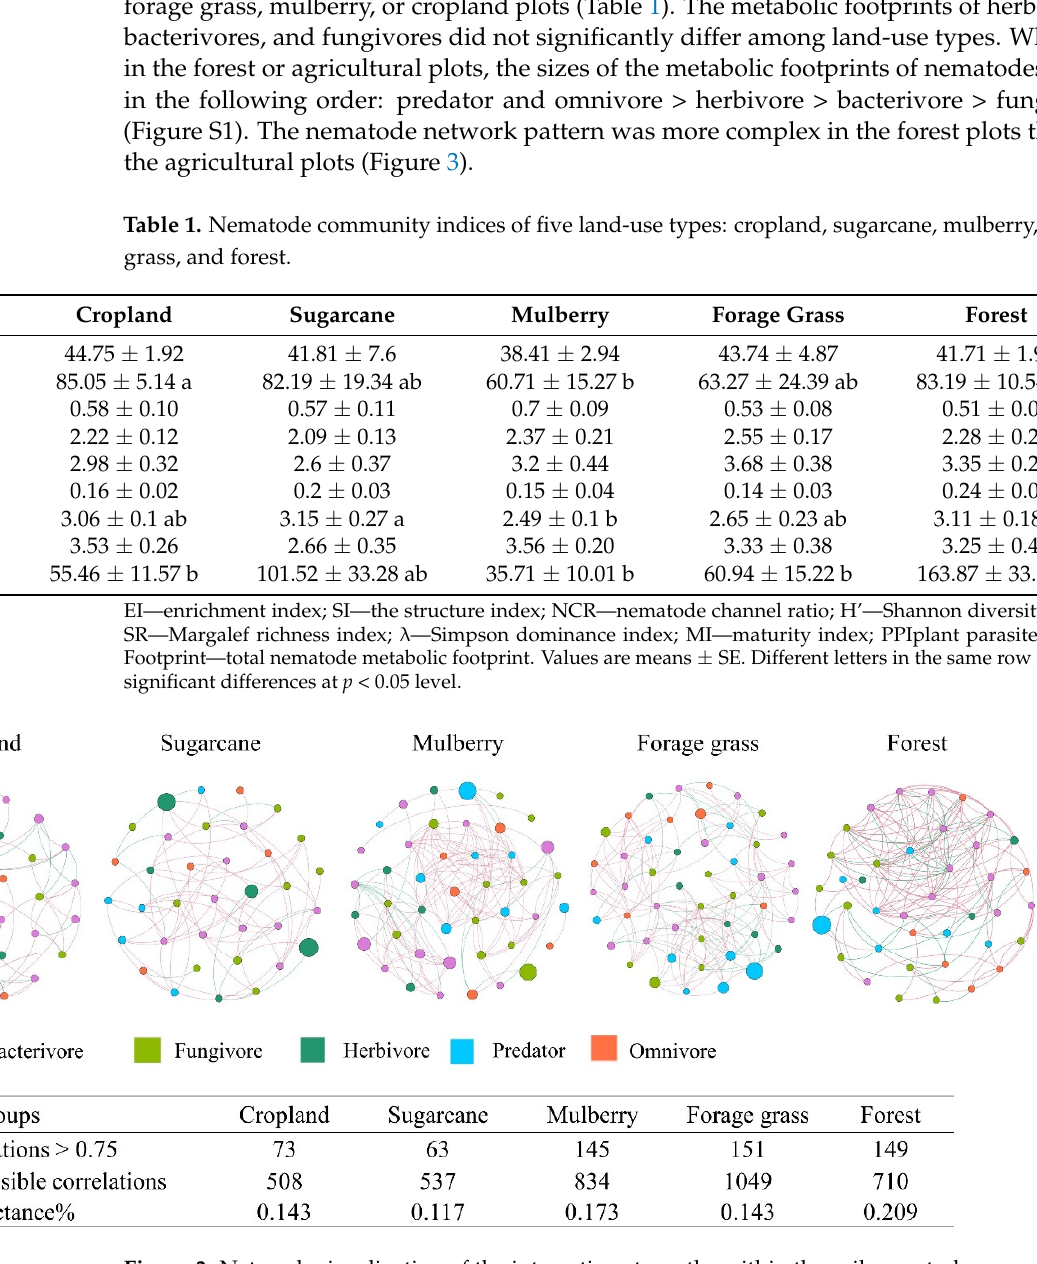
Figure 3. Network visualization of the interaction strengths within the soil nematode communities of cropland, sugarcane field, mulberry field, forage grass field, and mature forests. A connection stands for a strong (Spearman’s p > 0.75) correlation. The size of each node is proportional to the biomass of the nematode trophic group, and the nodes filled in purple are bacterivores, in light green are fungivores, in dark green are herbivores, in blue are predators, and in orange are omnivores. The connecting lines are colored according to interaction types; positive correlations are red, and negative correlations are green.